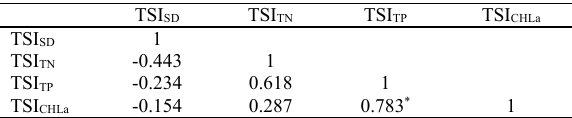
Table 7. Correlation analysis between TSIs